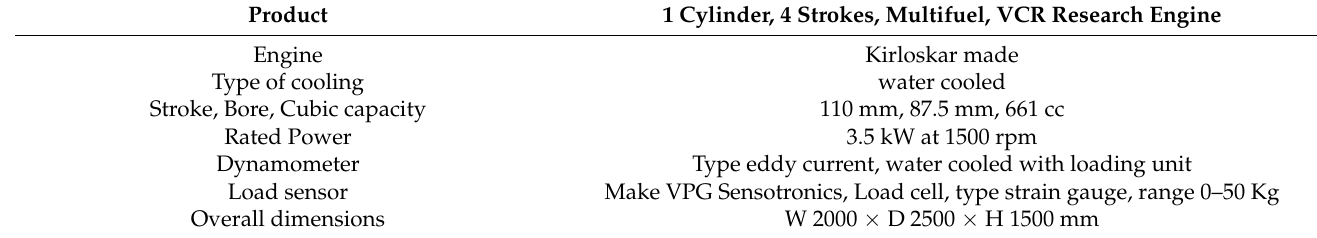
Table 3. Engine specification.